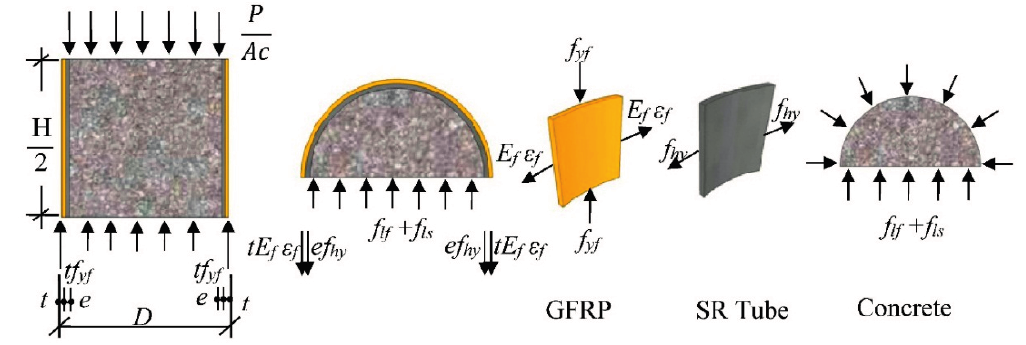
Figure 2. Confinement action of GFRP-SR-confined